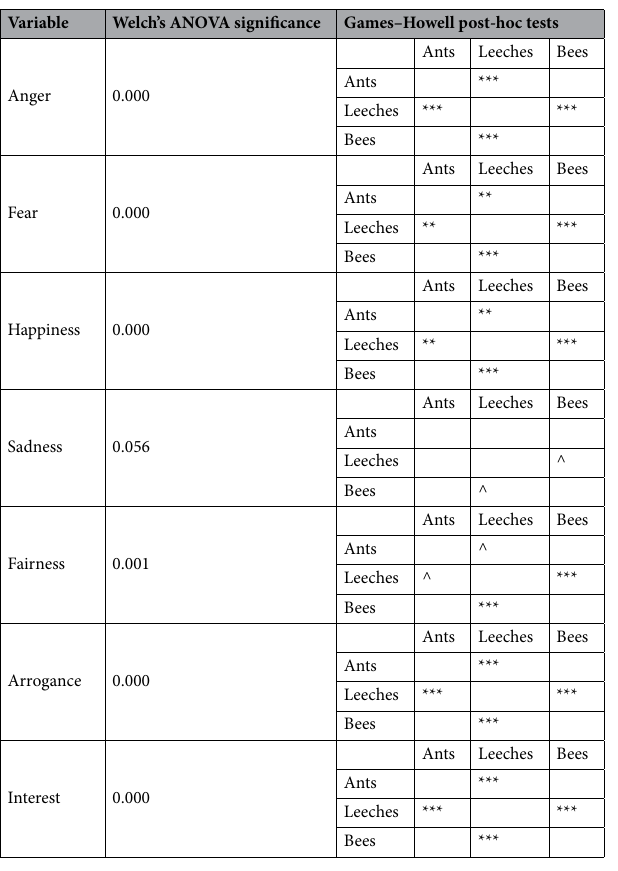
Table 2. Welch’s ANOVA—COINcourse dataset. ^p < 0.1; *p < 0.05; **p < 0.01; ***p <